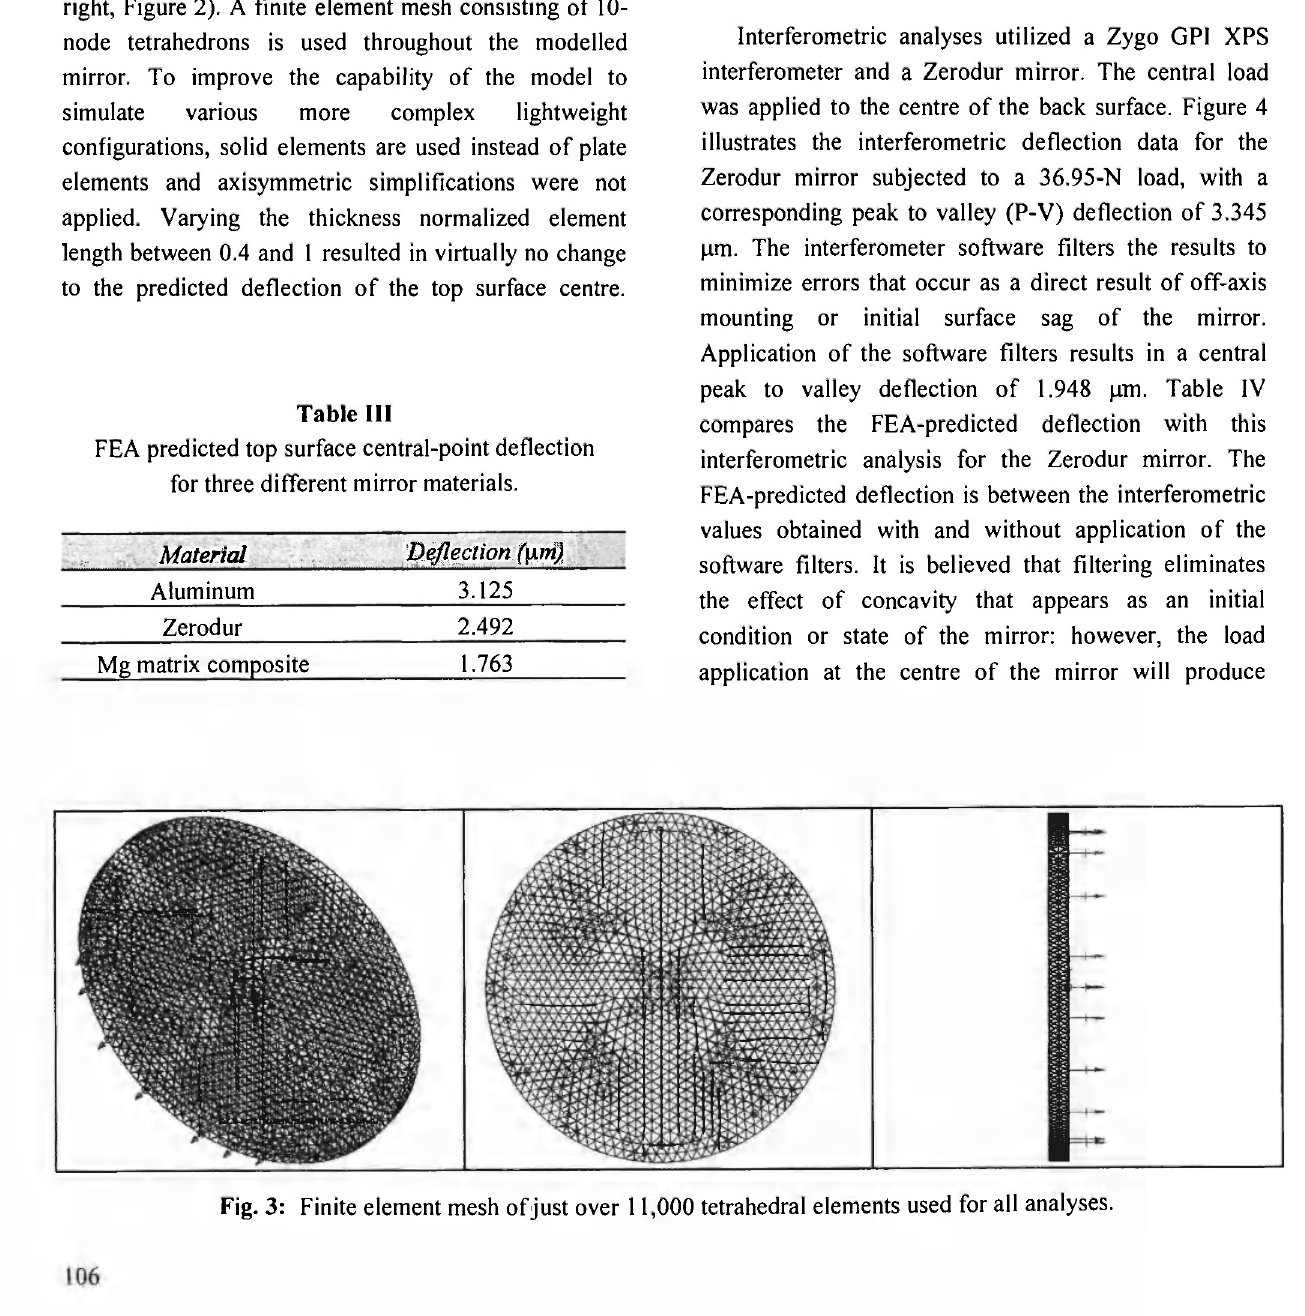
Fig. 3: Finite element mesh of just over 11,000 tetrahedral elements used for all